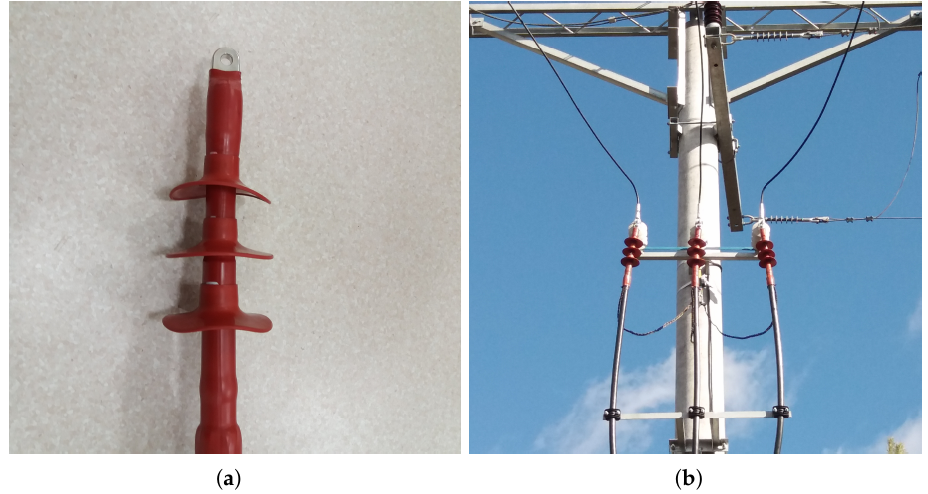
Figure 4. Heat shrinkable of MV cable termination type 24-EPOT-1/70-240/(U): ( a ) assembled cable head, ( b ) example of cable head application.